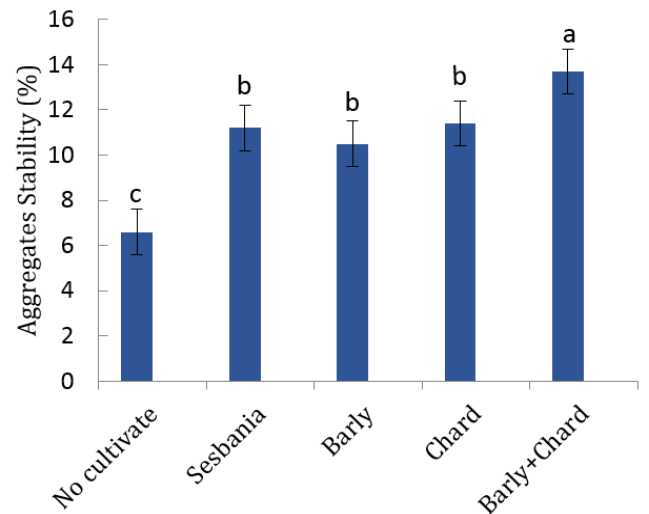
Figu re 1. Phytomanageme nt effe ct on the soil aggregates stab ility (% ) of th e surface laye r (0-30cm ) after thre e seasons . Value s represent mean ± SD